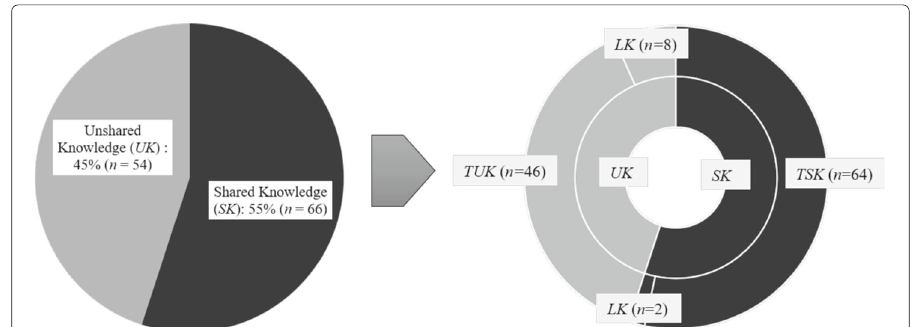
Fig. 4 Distribution of shared and unshared knowledge in individual maps prior to collaboration (left) and distribution of individual knowledge transferred to collaborative maps in all groups